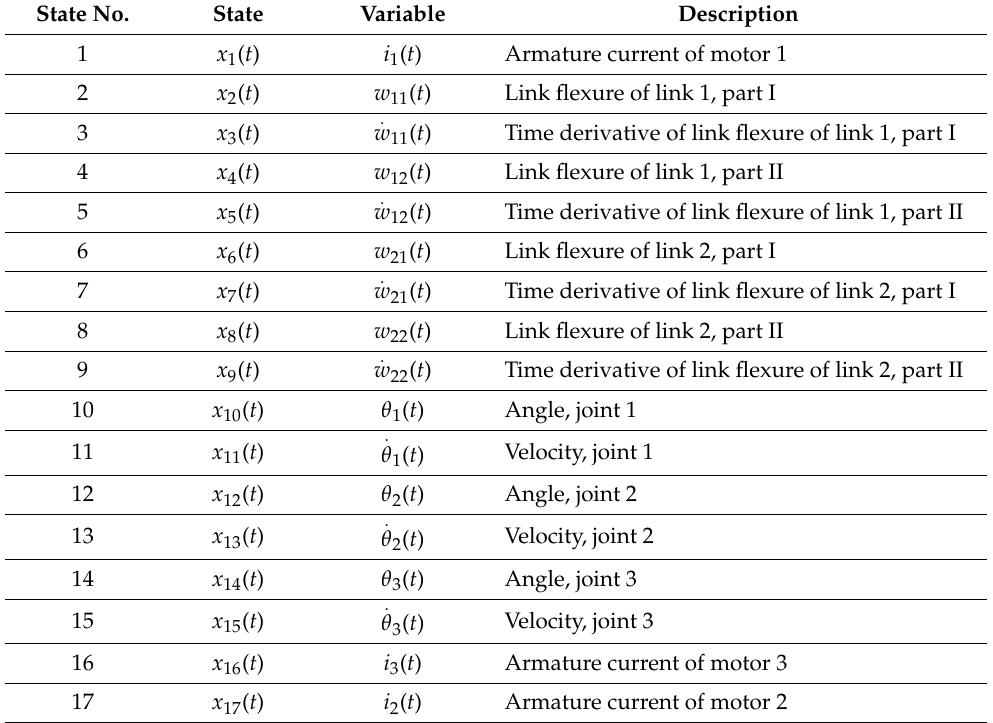
Table 2. States of Maplesim model. State